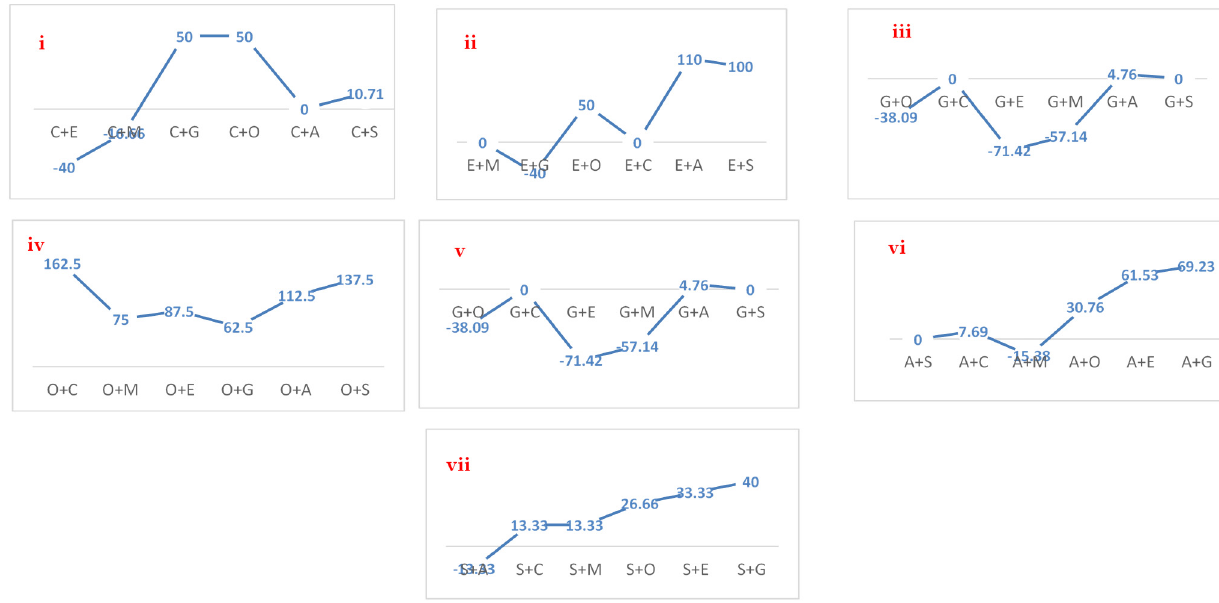
Figure 5. Percentage variation (increase/decrease) in zone of inhibition (ZOI) of individual drugs when compared with their combinations with other drugs. ( i )—% variation in ZOI of Co-amoxiclav (C) when it was compared with its combination with other drugs; ( ii )—% variation in ZOI of Enrofloxacin (E) when it was compared with its combination with other drugs; ( iii )—% variation in ZOI of Gentamicin (G) when it was compared with its combination with other drugs; ( iv )—% variation in ZOI of Oxytertracylin (O) when it was compared with its combination with other drugs; ( v )—% variation in ZOI of Metronidazole (M) when it was compared with its combination with other drugs; ( vi )—% variation in ZOI of Amoxicillin (A) when it was compared with its combination with other drugs, ( vii )—% variation in ZOI of Streptomycin (S) when it was compared with its combination with other drugs.